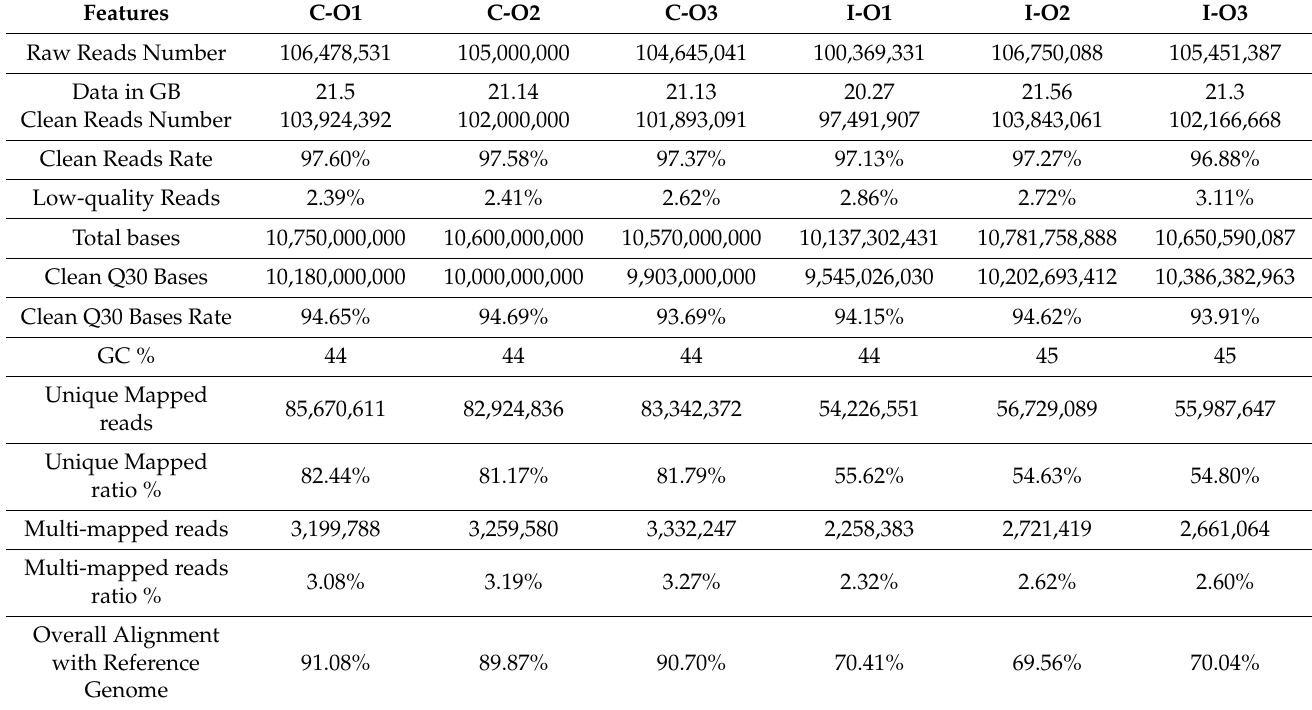
Table 1. A summary of the RNA sequencing